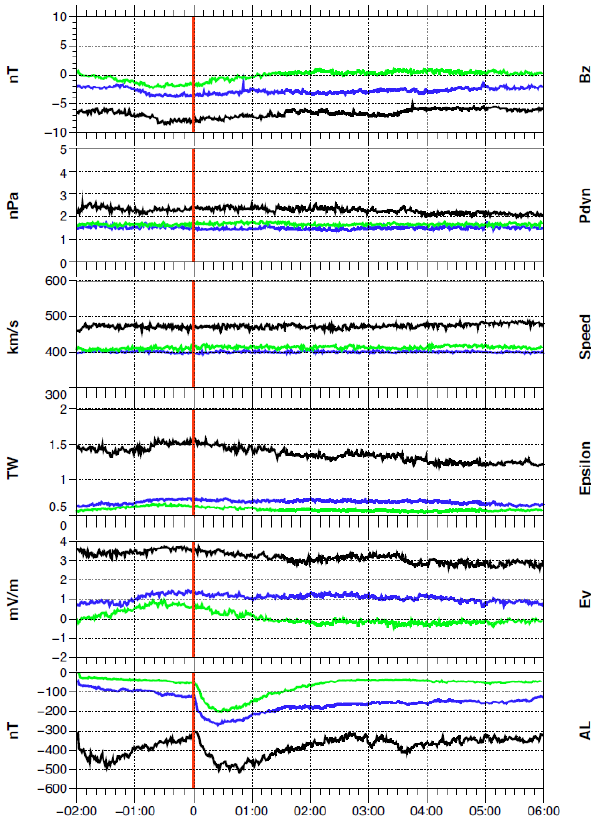
Fig. 4. Superposed epoch curves solar wind E Y , AL index, polar cap potential as well as coupling efficiencies as AL/ E Y and PC/ E Y for sawtooth events (black), SMC periods (blue), and isolated sub- storms (green).